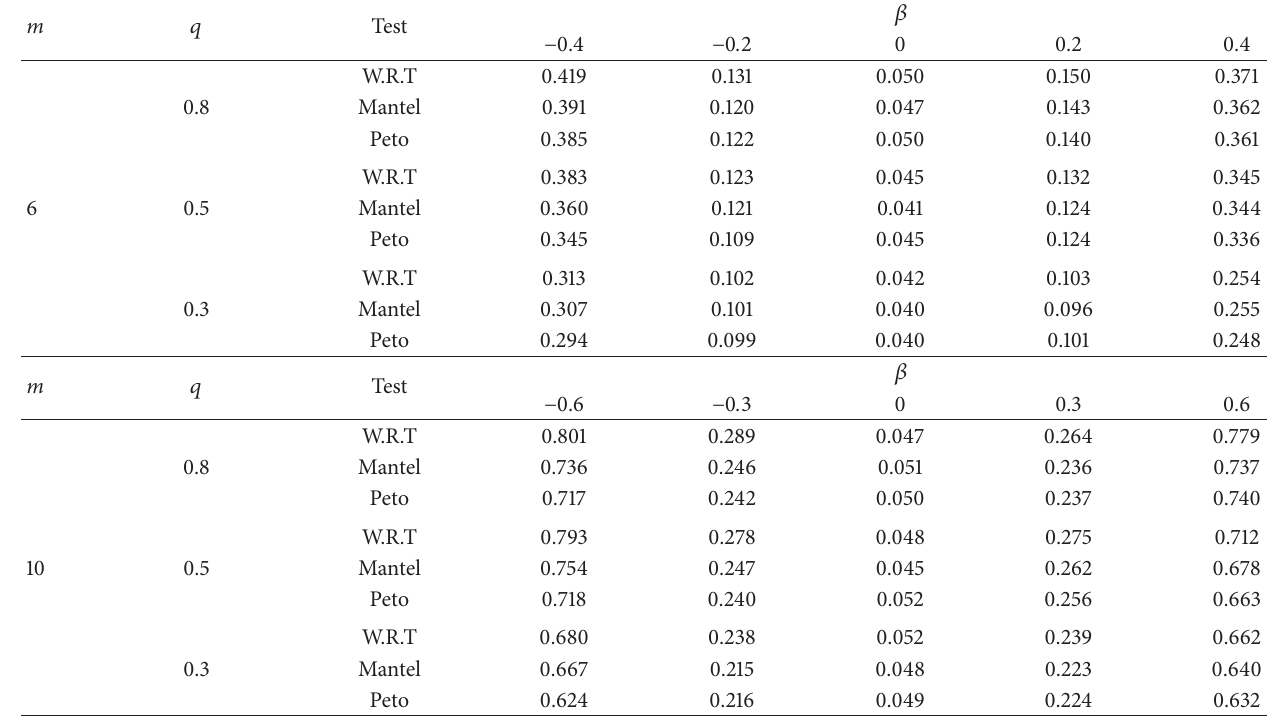
Table 5: Power comparison of tests under exponential distribution with sample 𝑛 = 100 .